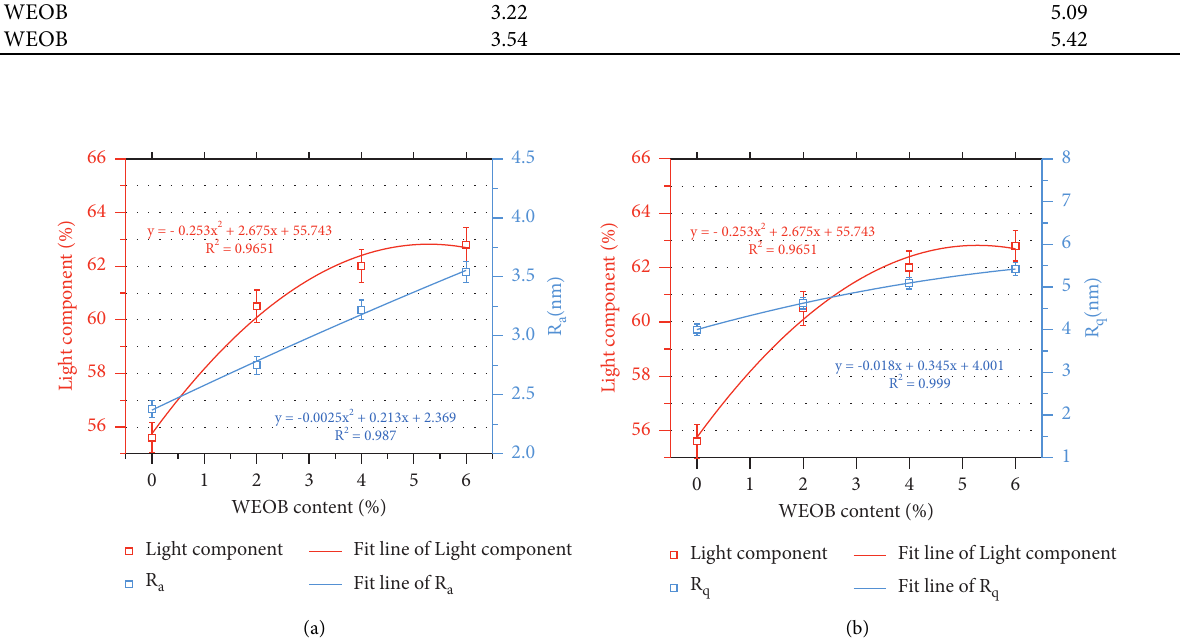
Figure 15: (a) R a and (b) R q of the specimens with different WEOB